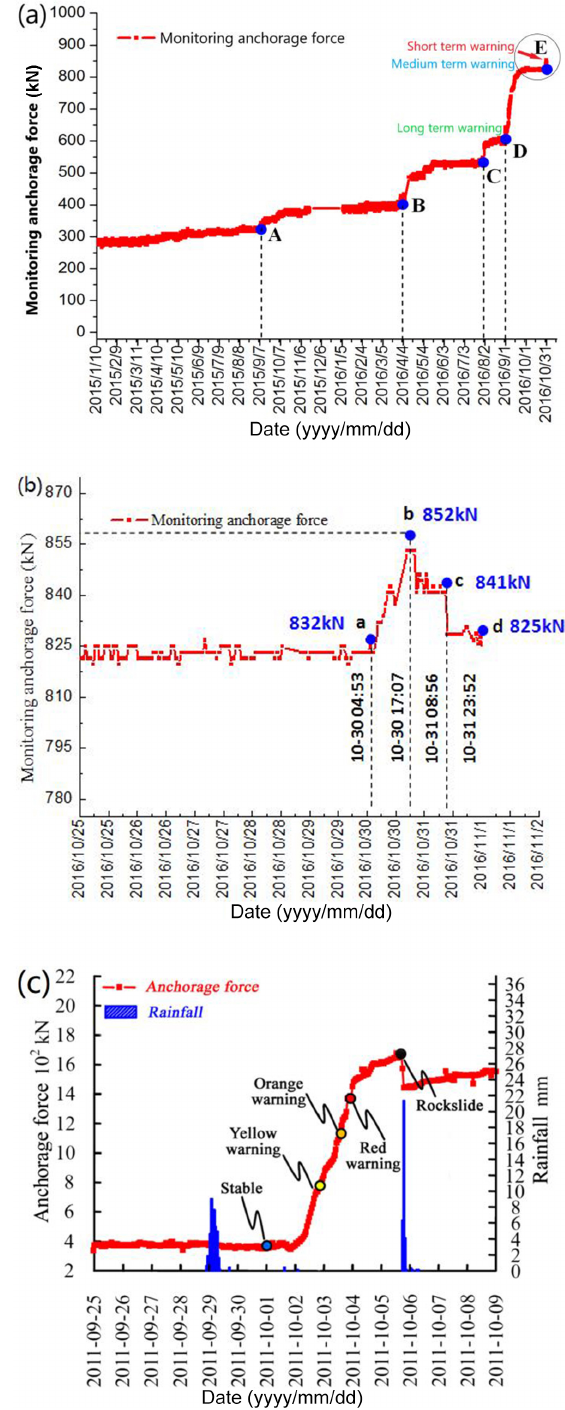
Figure 7. Real-time monitoring curve of the anchorage force. (a) Points A–E represent five sudden increases before the rockslide in 2016. (b) Anchorage force during the rockslide in 2016 (partially enlarged from panel a). (c) Monitoring anchorage force during the rockslide in 2011 (Li et al.,